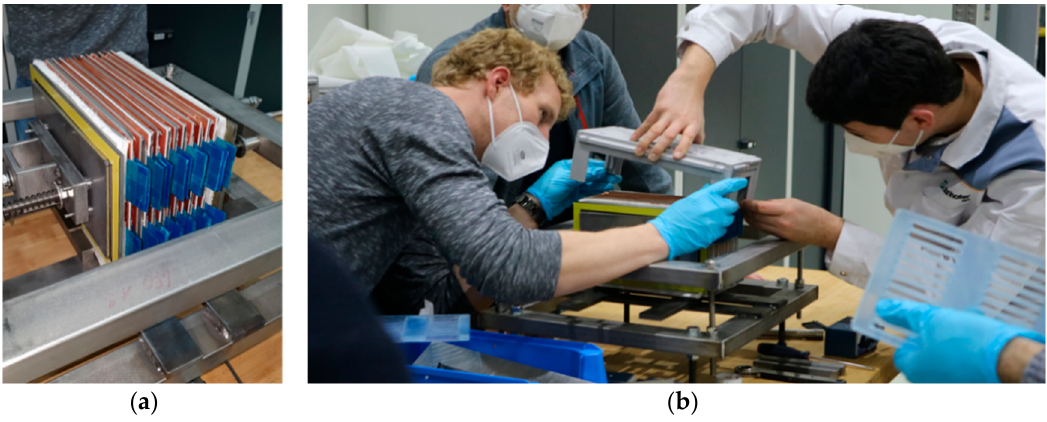
Figure 8. ( a ) Device for inserting the battery cells into the battery module housing halves and joining them and joined battery module housing. ( b ) A dummy battery-cell stack made of wooden elements of the same thickness was used for testing.